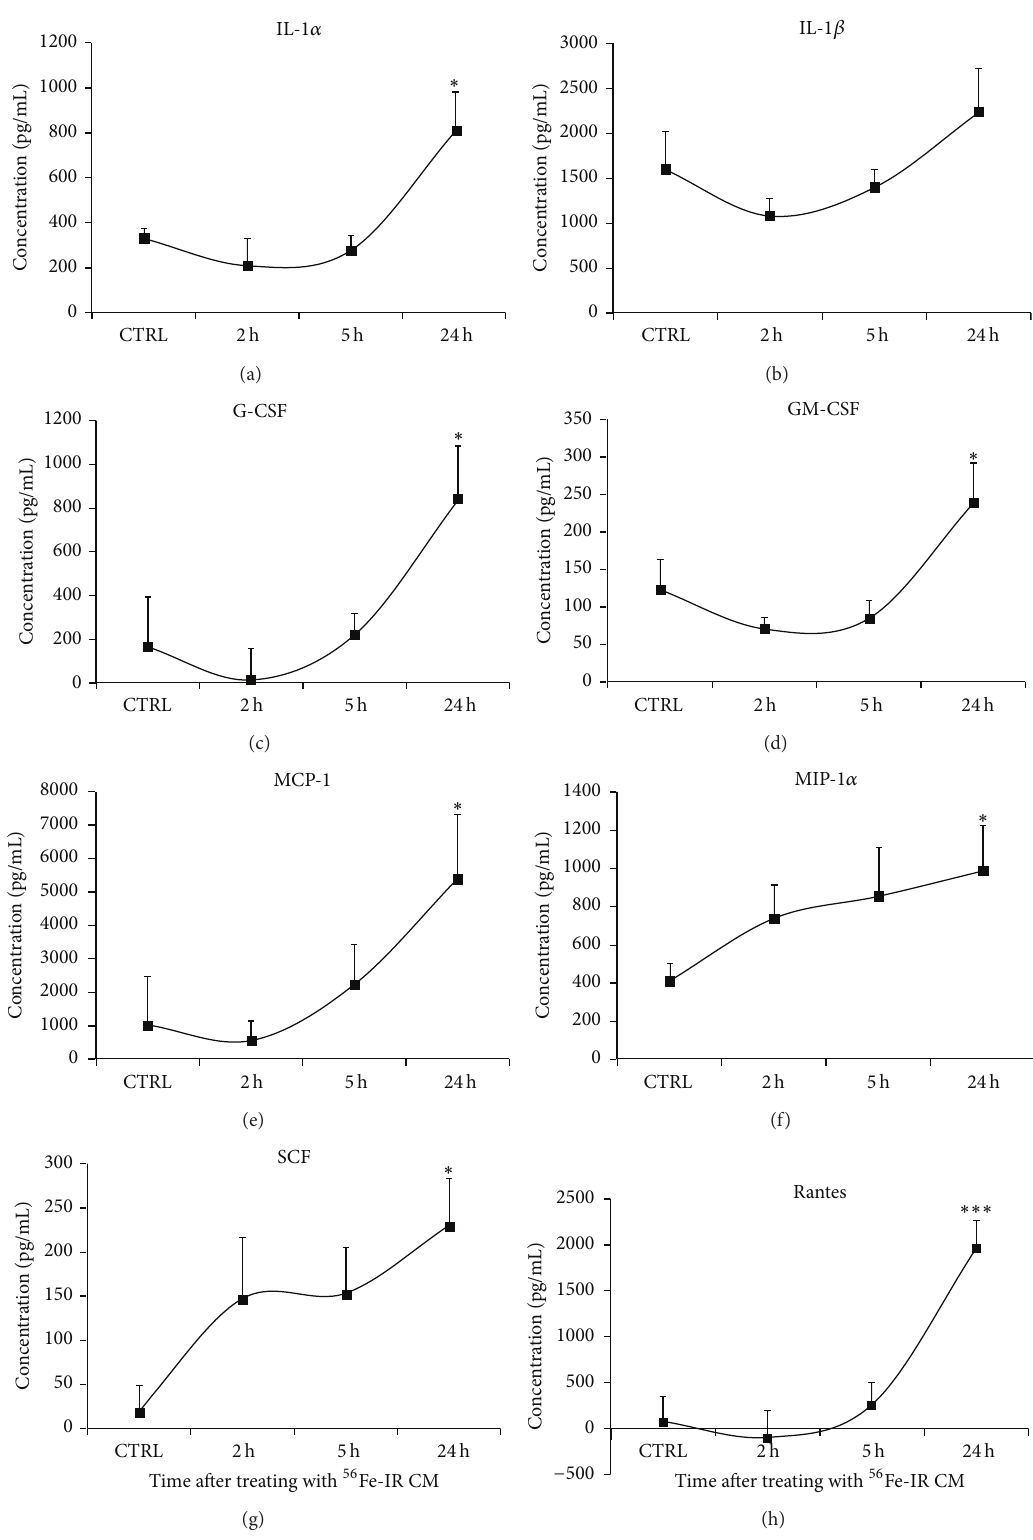
Figure 5: Cumulative levels of inflammatory cytokines and chemokines are significantly increased in 56 Fe-IR conditioned medium. Graphic representation of IR-induced increase in the cumulative concentration (pg/mL) of cytokines, chemokines, and growth factors in CM from 15cGy 56 Fe-IR BM-EPCs in vitro at 2, 5 and 24 hours post-IR for (a) IL-1 𝛼 , (b) IL-1 𝛽 , (c) G-CSF, (d) GM-CSF, (e) MCP-1, (f) MIP-1 𝛼 , (g) SCF, and (h) Rantes. Graphs represent mean ± SEM of the pooled data from 3 independent biological samples/experiments. Statistical significance was assigned when 𝑃 < 0.05